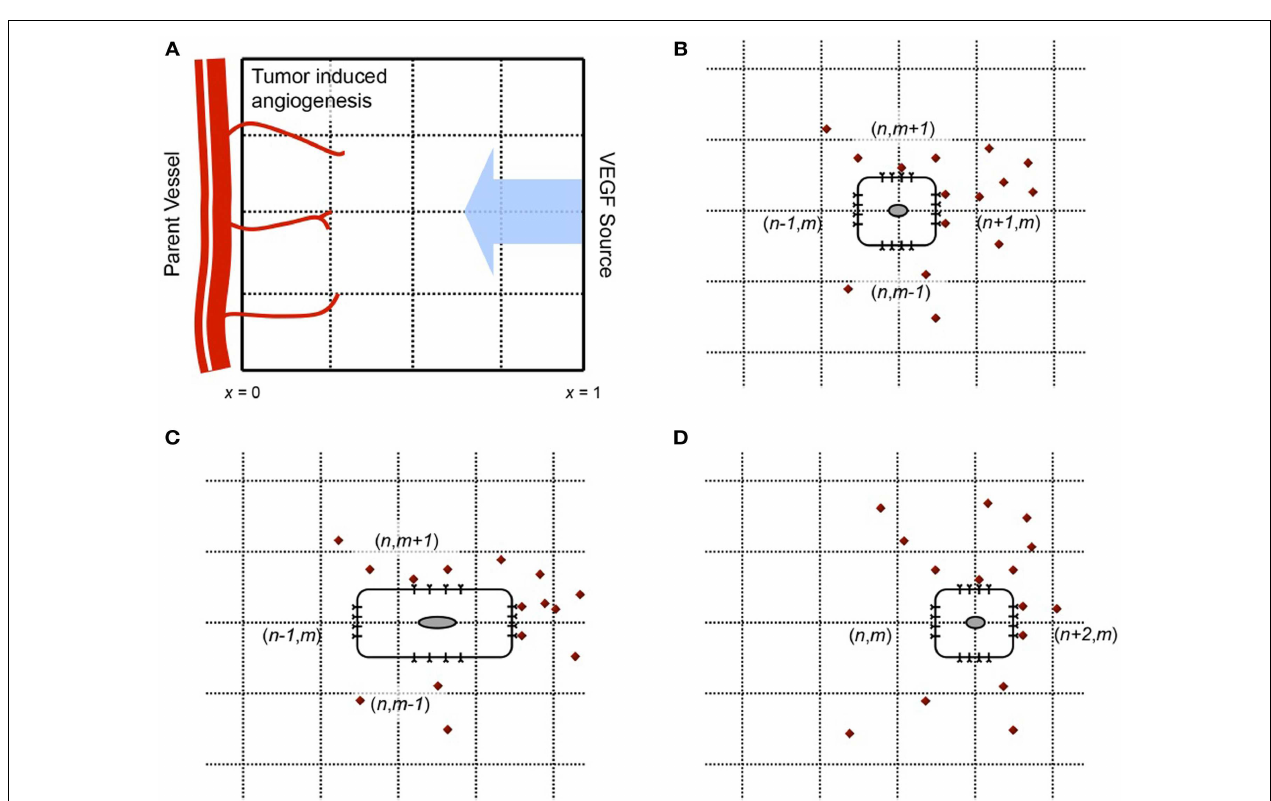
begins at position ( n , m ) in (B) .VEGF molecules are shown in red.The number of activatedVEGF-receptors is greatest on the cell surface at lattice site ( n + 1 / 2, m ), and the probability of motion in this direction is the greatest. Consequently, the cell is likely to move from site ( n , m ) to ( n + 2, m ), as shown in (C,D)